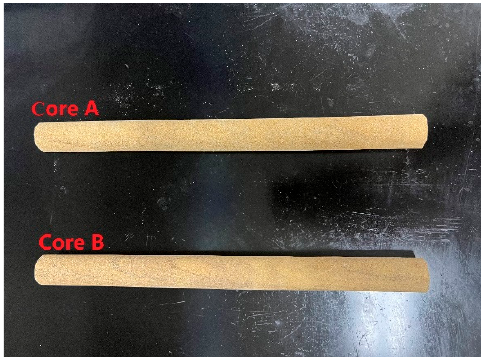
Figure 3. Physical picture of cores. Core A-300mD, Core B-600mD.